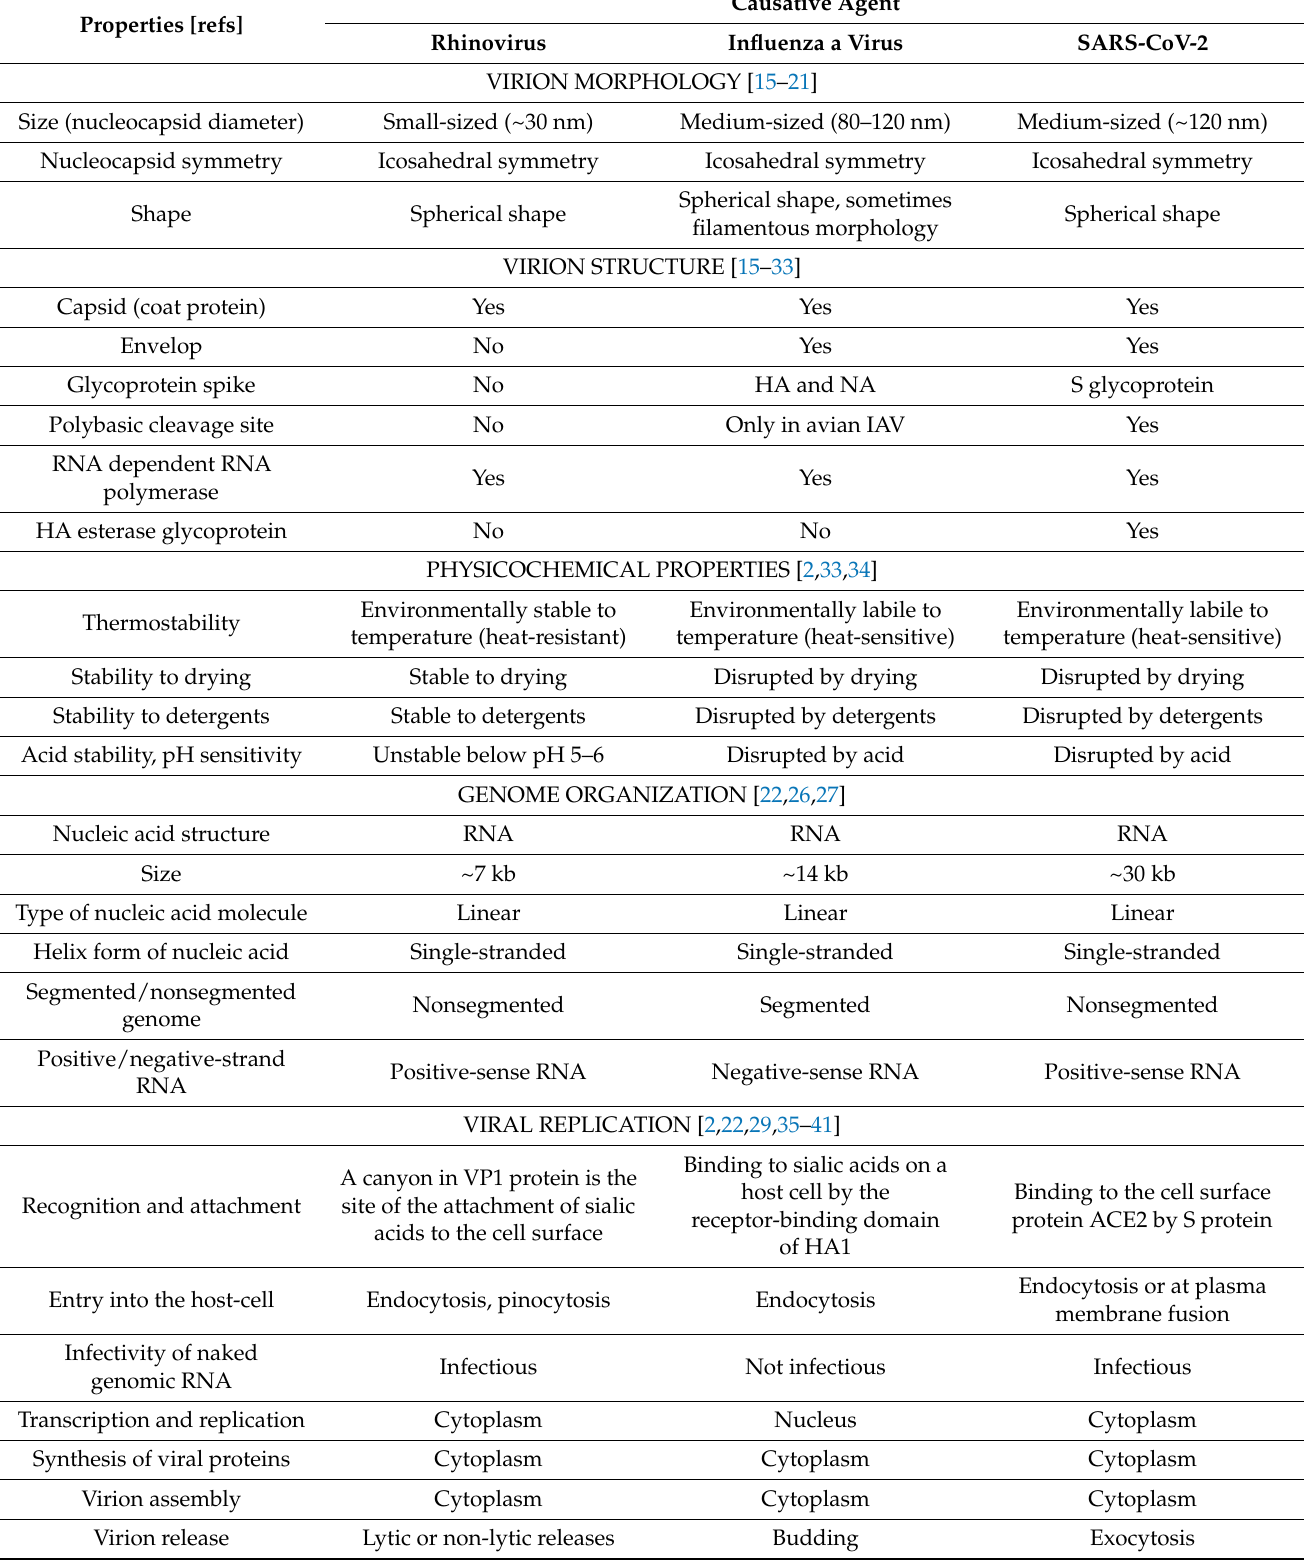
Table 1. Comparative characteristics of HRV, IAV, and SARS-CoV-2: organization and